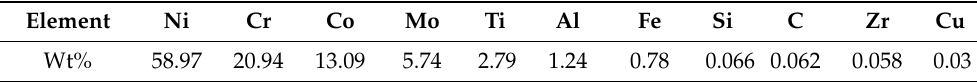
Table 1. Composition by wt. % for Waspaloy.